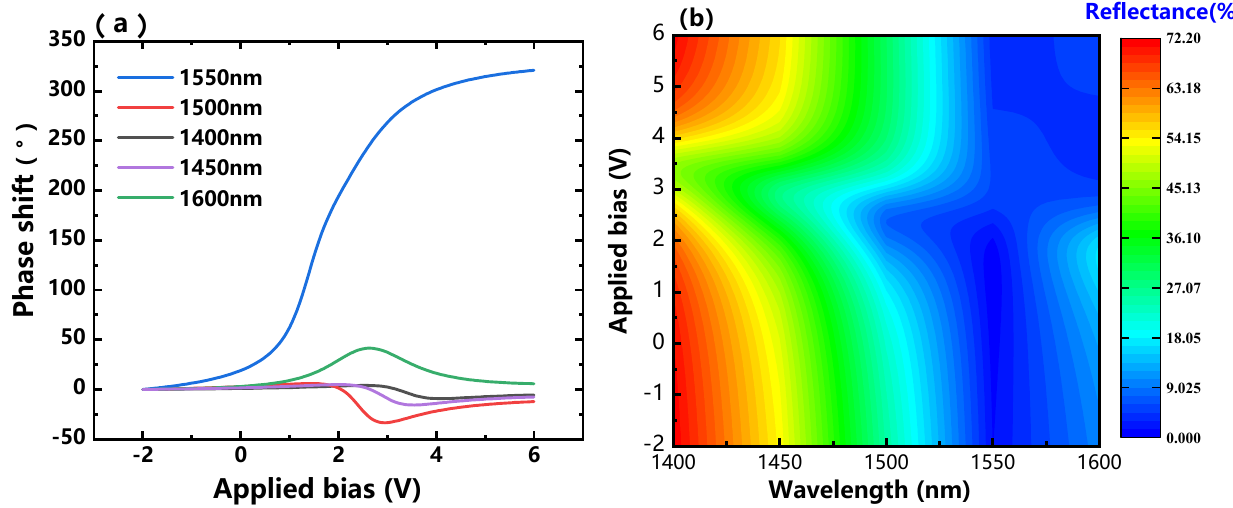
Figure 3. ( a ) Phase modulation as a function of applied bias for different wavelengths, from 1400 nm to 1600 nm. ( b ) Simulated reflectance as a function of the applied bias voltage at different wavelengths.